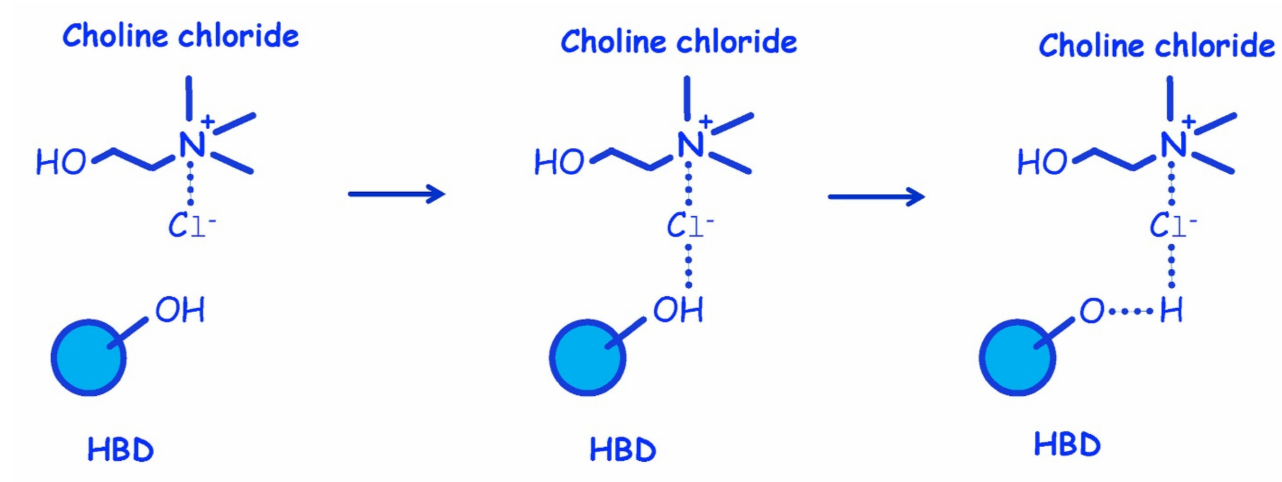
Figure 2. Synthesis of choline chloride-HBD DES: hydrogen bond formation. Reprinted with permission from